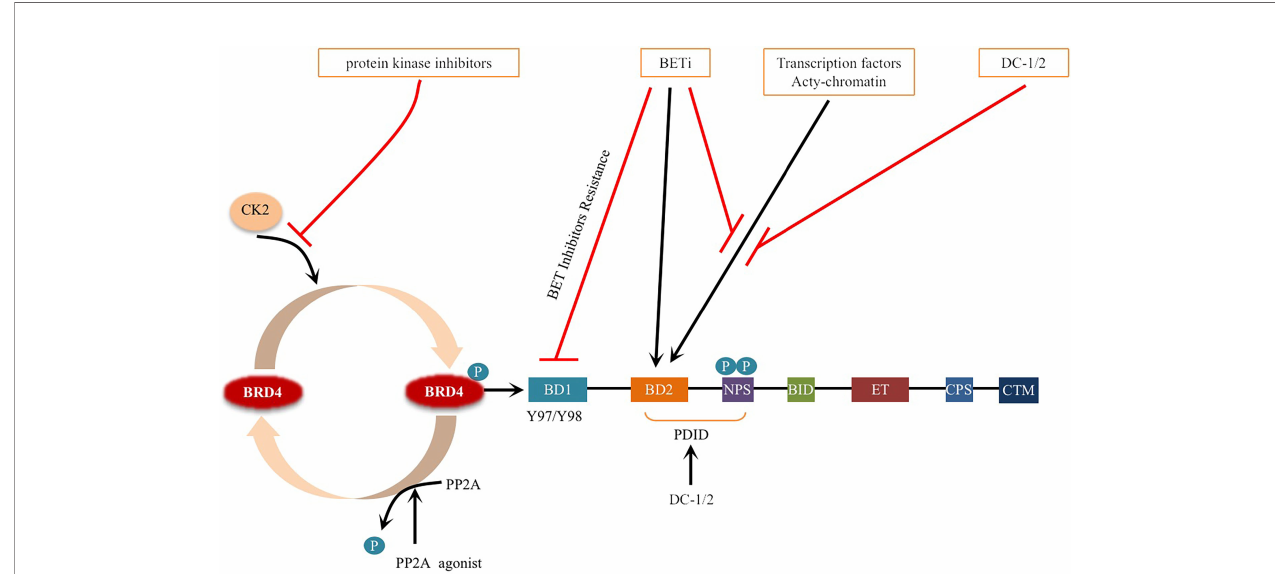
FIGURE 3 | Schematic representation of BRD4 phosphorylation and dephosphorylation: BRD4 intramolecular phosphorylation switch is triggered by CK2 and PP2A, which regulates its function in chromatin targeting, factor recruitment and cancer progression through CK2 phosphorylation and PP2A dephosphorylation. Phosphorylation of Y97/98 at the bromodomain BD1 of BRD4 leads to reduced binding to BETi, resulting in drug resistance. Phosphorylation of (NPS) is the key to BRD4 binding to acetylated chromatin and recruitment of transcription factors to target gene sequences. BETi inhibitors compete with acetylated chromatin, transcription factors to bind to the bromodomain. DC-1/2 was developed for targeting phospho NPS, mediating speci fi c transcription and factor recruitment. Protein kinase inhibitors inhibit the phosphorylation of BRD4. Small molecule activators of PP2A enzyme activity promote the dephosphorylation of BRD4 and prevent BRD4 from binding to acetylated nucleosomes and possibly acetylated transcription factors. Black arrows indicate positive effects. Red perpendicular bars indicate negative